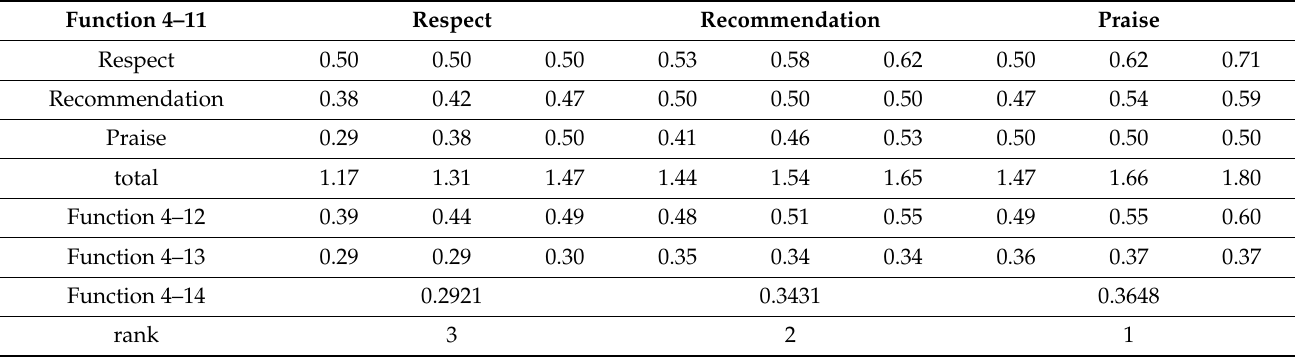
Table A10. Travel agencies’ weights of attributes of the social